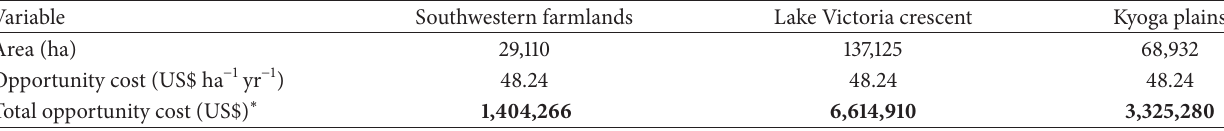
Table 14: Opportunity costs of limiting community access to wetlands in three agro-ecological zones in